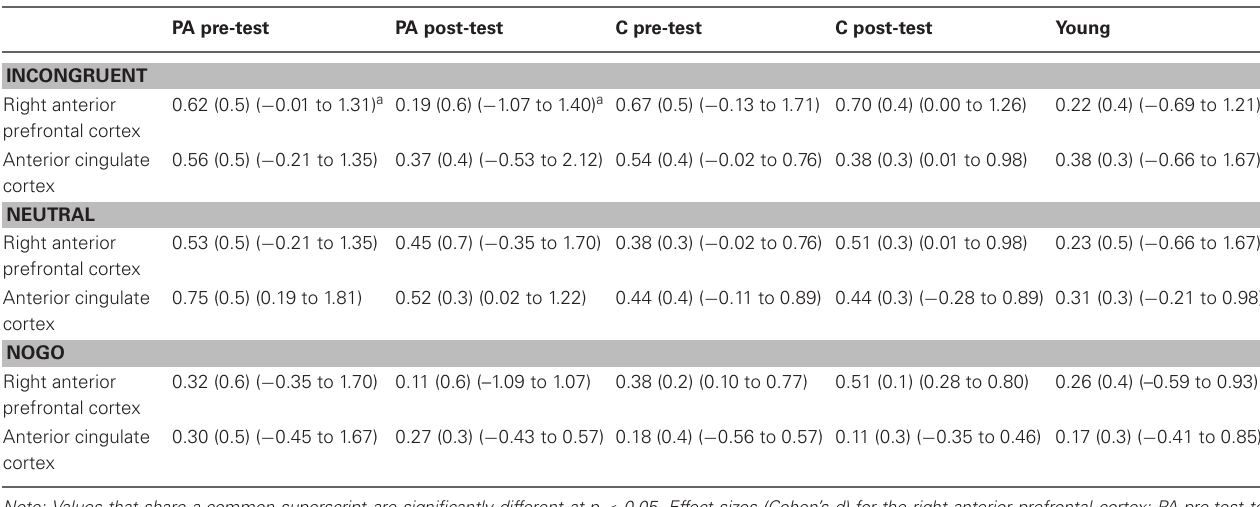
Table 3 | Mean percent signal change (SD) (range) for the physical activity (PA) and control (C) child groups and the young adult group during incongruent, neutral and NoGo task trials (versus